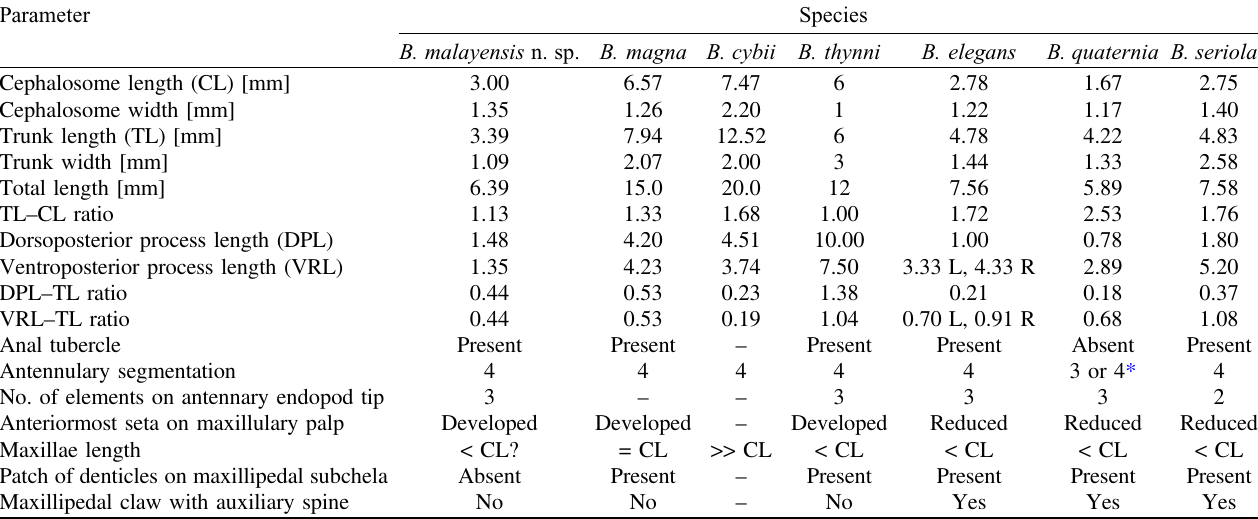
Table 1. A comparison of morphometric and meristic features of females of Brachiella